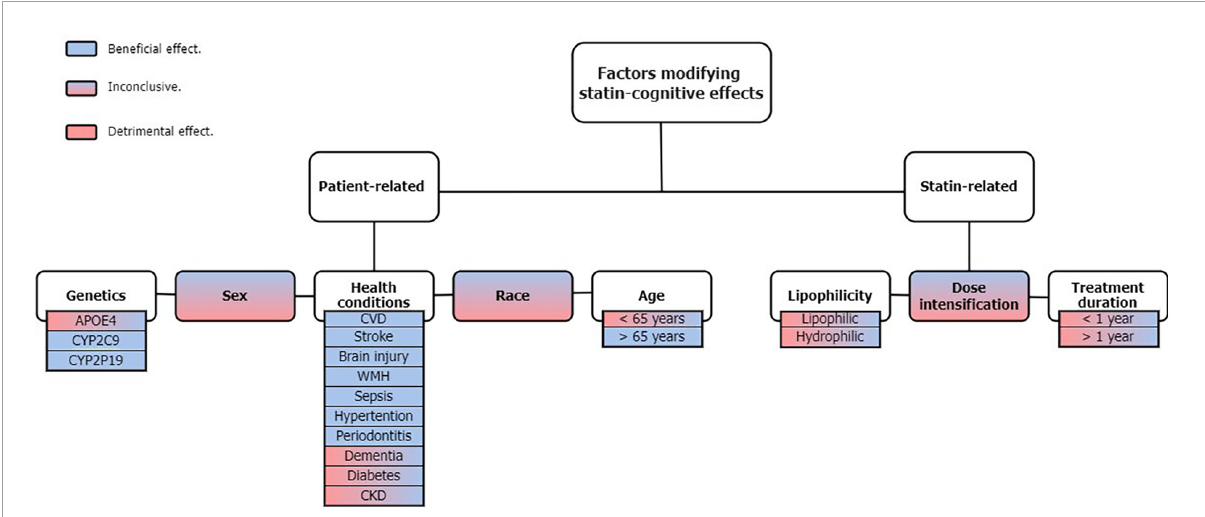
FIGURE1 Classification of recognized factors that can modify the statin effect on cognitive function. APOE4, apolipoprotein E isoform 4; CYP2C9, cytochrome P450 family 2 subfamily C member 9; CYP2P19, cytochrome P450 2 subfamily C member 19; CVD, cardio vascular disease; WMH, white matter hyperintensities; CKD, chronic kidney